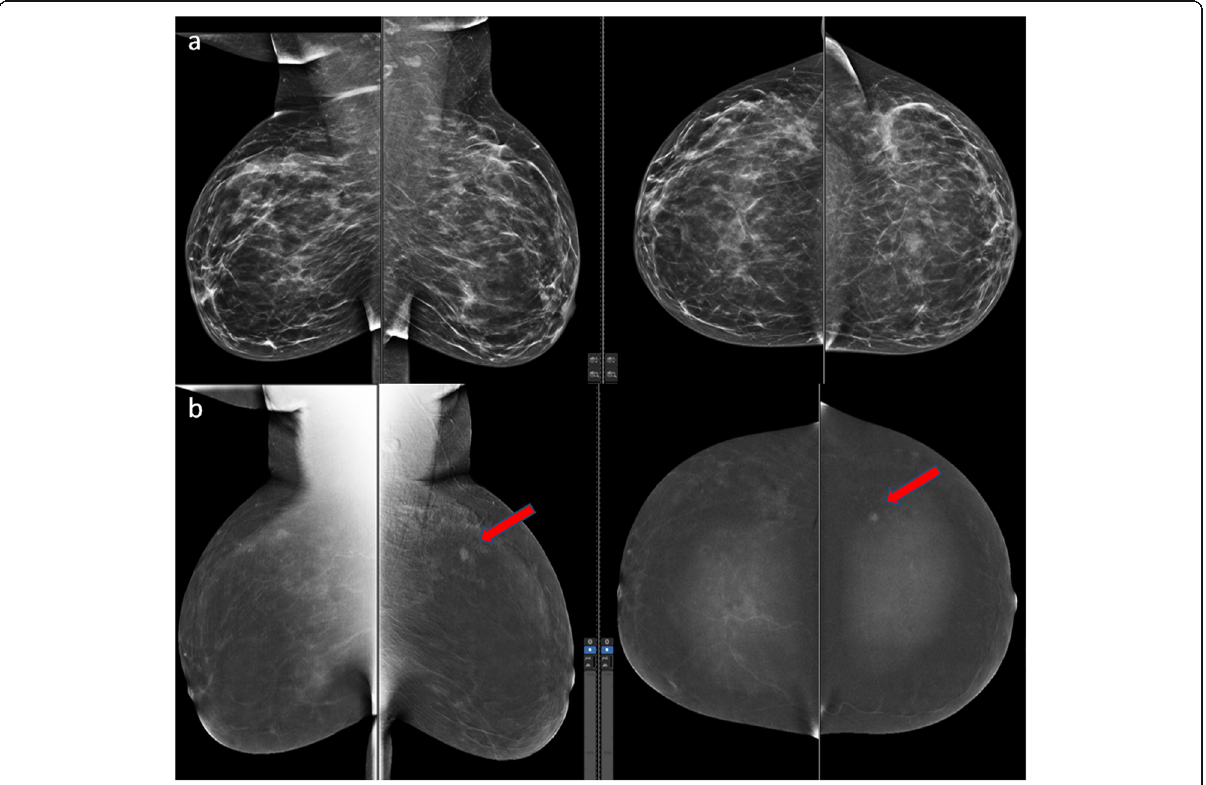
Fig. 2 A 42-year-old female coming for screening with family history of breast cancer (mother and aunt). a FFDM showed heterogeneously dense fibro-glandular parenchyma ( ACR C ), no right or left breast lesions ( BIRADS 1 ). b CESM showed no right breast lesions ( BIRADS 1 ) and left UOQ small enhancing circumscribed lesion ( BIRADS 3 ). Histopathology : left breast fibroadenoma. Comment : CESM showed an underlying lesion not seen in